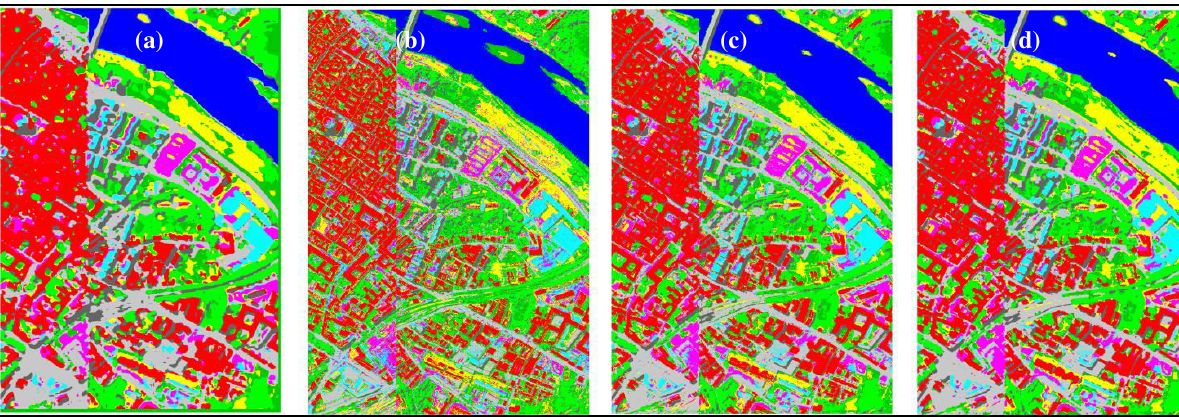
Figure 4. Pavia Center classification results using the best decision fusion rule; (a) SVM classification of HS image, (b) SVM classification of MS image, (c) Classification fusion by Dempster-Shafer rule, (d) Global classification